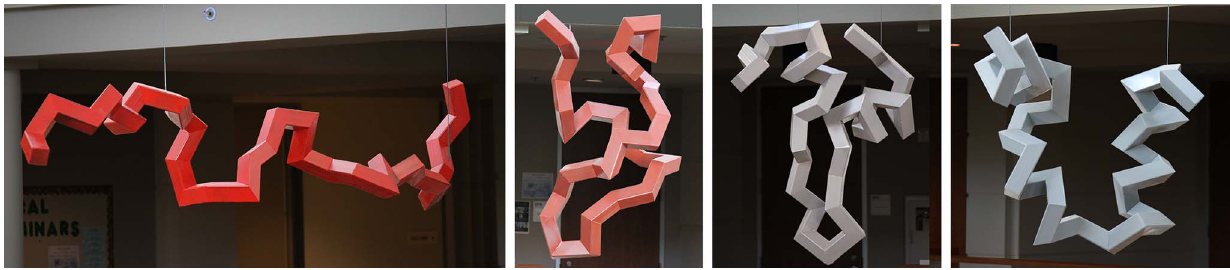
Figure 2. Each component of the sculpture represents a snapshot of a protein as it contorts from open chain (red) to native fold (gray).